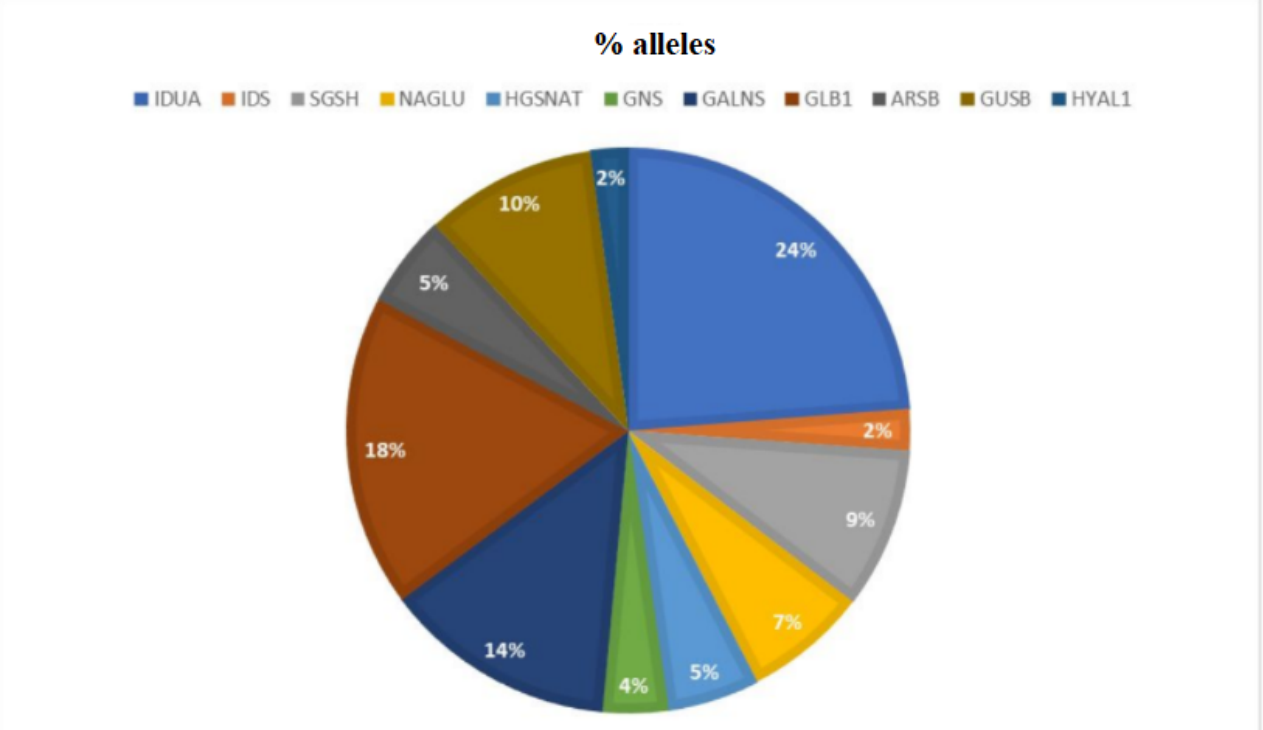
Figure 1. Percentage of alleles found in genes associated with the MPS